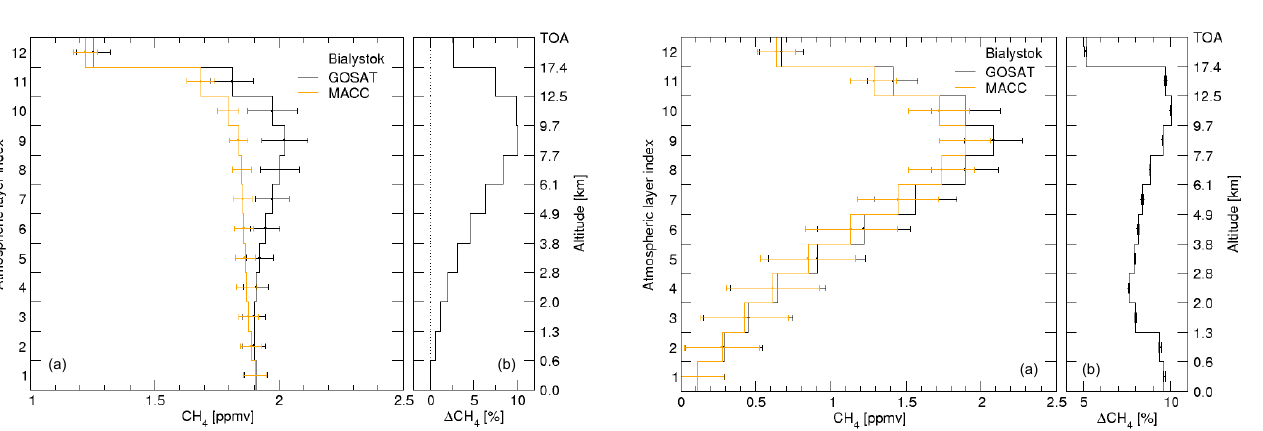
Figure 6. (a) Averaging kernel-smoothed profiles from GOSAT daytime measurements over land (black) and MACC (orange) at TCCON station Bialystok. The bars indicate the spread in the data ensemble. (b) The relative difference between the profiles. The bars pertain to the 1 σ uncertainty of the averaged ratio, derived from the instrument noise